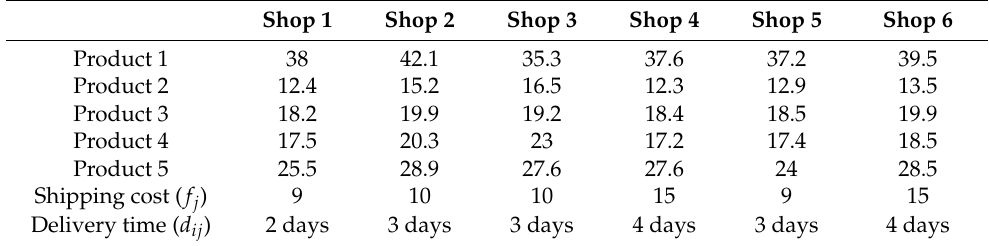
Table 8. Skincare sales data on